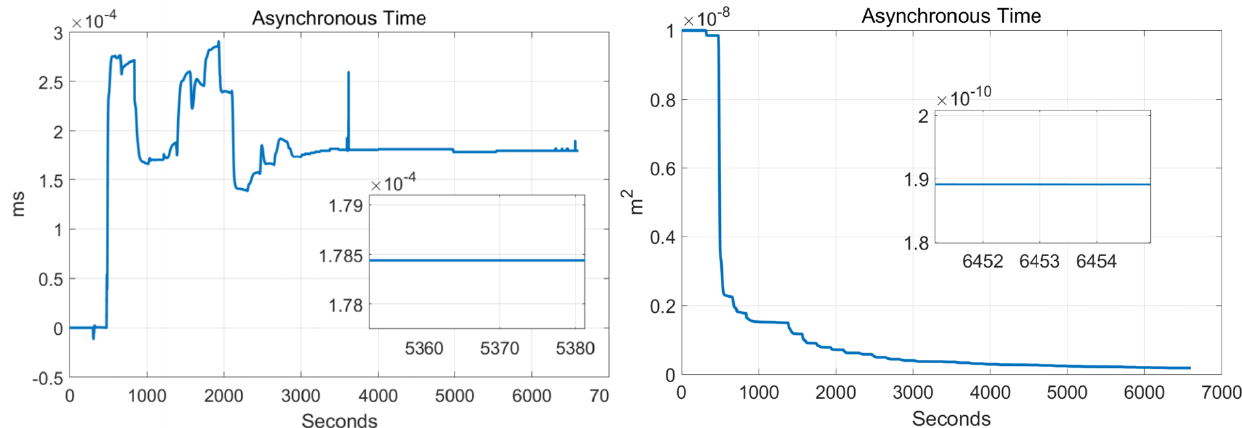
Figure 13. Asynchronous